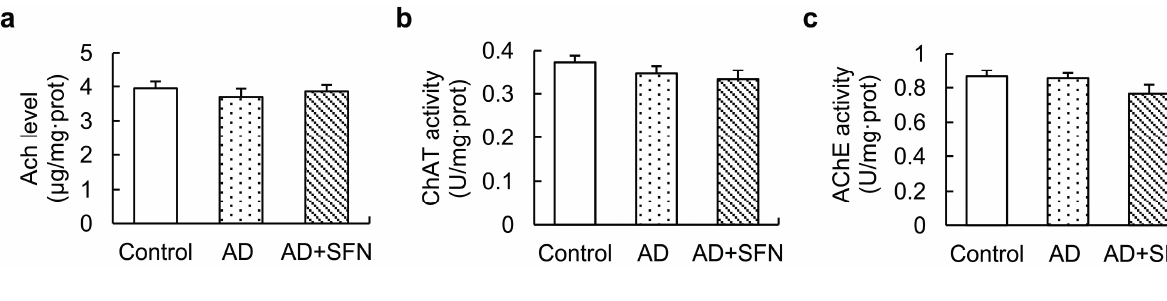
Figure 6. Acetylcholine (Ach) level and activities of ChAT and acetylcholinesterase (AChE) in the cerebral cortex. ACh level ( a ) and activities of ChAT ( b ) and AChE ( c ) in the cerebral cortex did not differ significantly among controls, AD-like mice and AD + SFN-like mice. ( n = 10; means ± S.E.M.; One-way analysis of variance followed by post hoc least significant difference multiple comparison